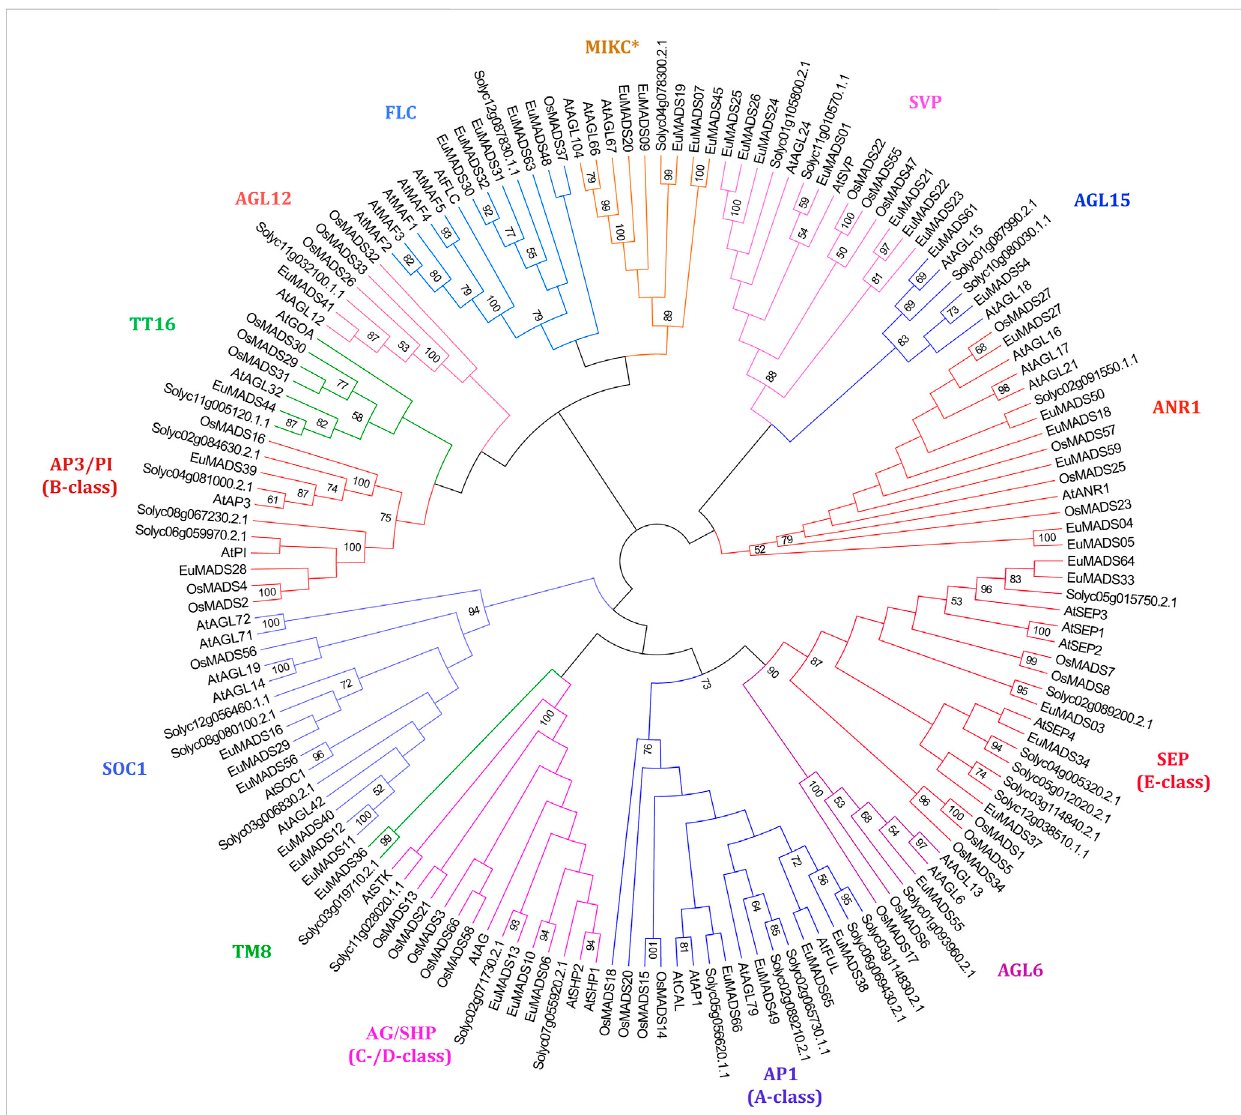
FIGURE 4 Maximum likelihood tree of MIKC MADS-box transcription factors in E. ulmoides , A. thaliana , S. lycopersicum and Oryza sativa . MIKC* clade and 13 known MIKC C subgroups are indicated in different